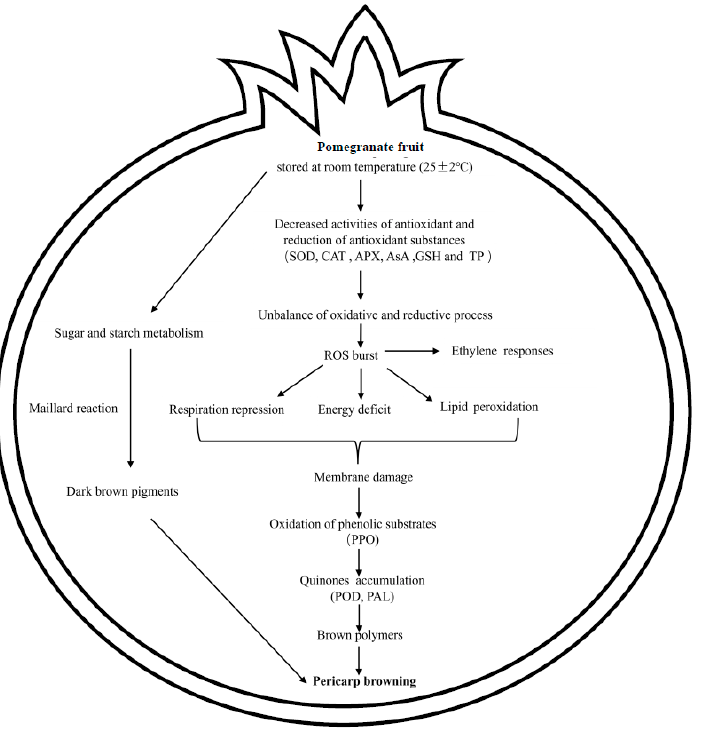
Figure 9. A Schematic of the pericarp browning of pomegranate fruit. Abbreviation: ROS, reactive oxygen species; SOD, superoxide dismutase; CAT, catalase; APX, ascorbate peroxidases; AsA, ascorbic acid; GSH, glutathione; TP, total phenolics; PPO, polyphenol oxidase; POD, peroxidase; PAL, phenylalanine ammonia lyase.